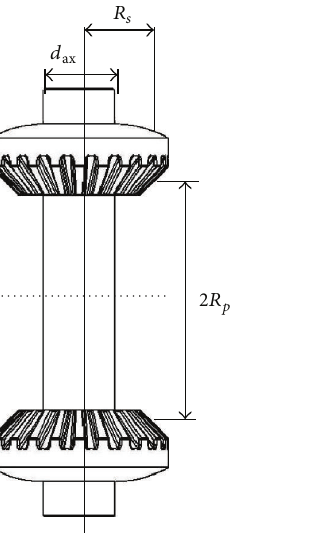
Figure 6: Satellite bevel pinions and satellite-carrier axis.